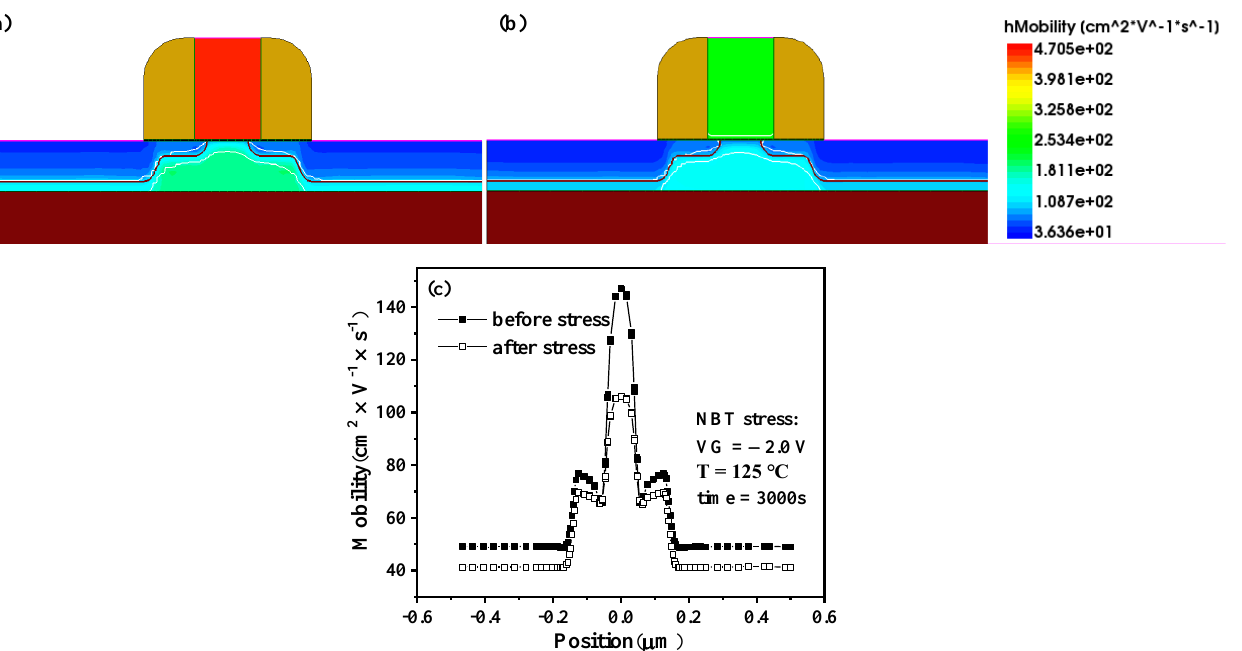
Figure 4. Distribution of interface trap concentration in PMOSFET.